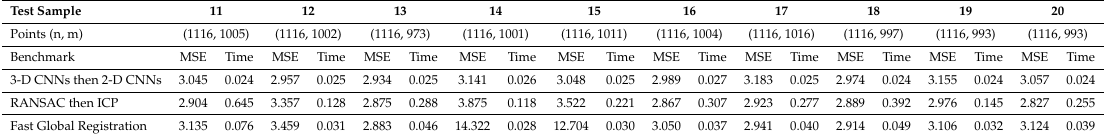
Table 2. The comparisons about MSE and computation time of “Bunny” data for test samples from 11 to 20. TestSample